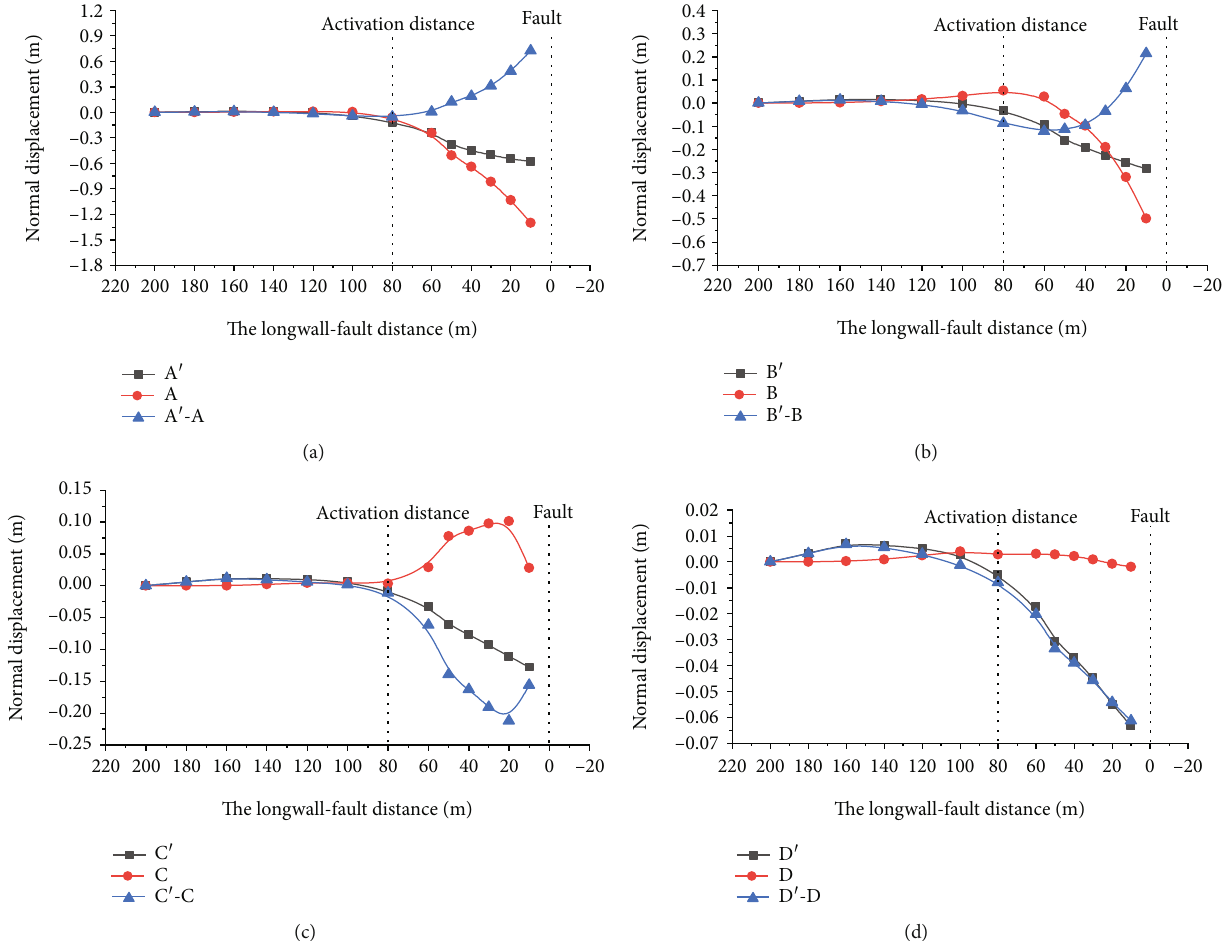
Figure 9: Vertical displacement of eight monitoring points and displacement di ff erence of adjacent